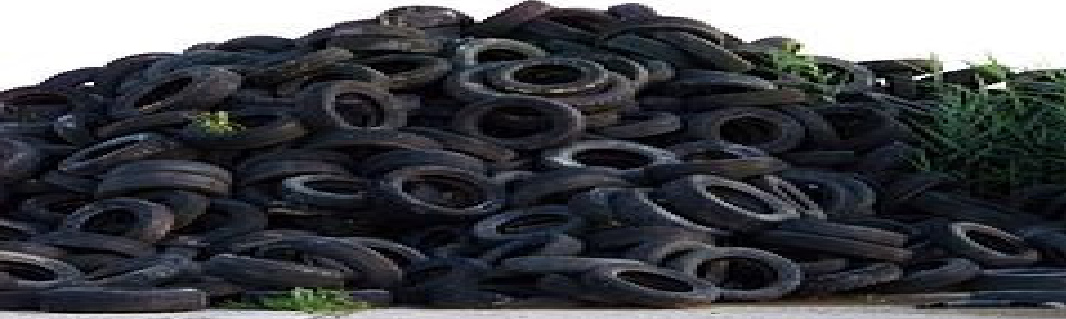
Fig. 2: Vulcanizing Used tyre